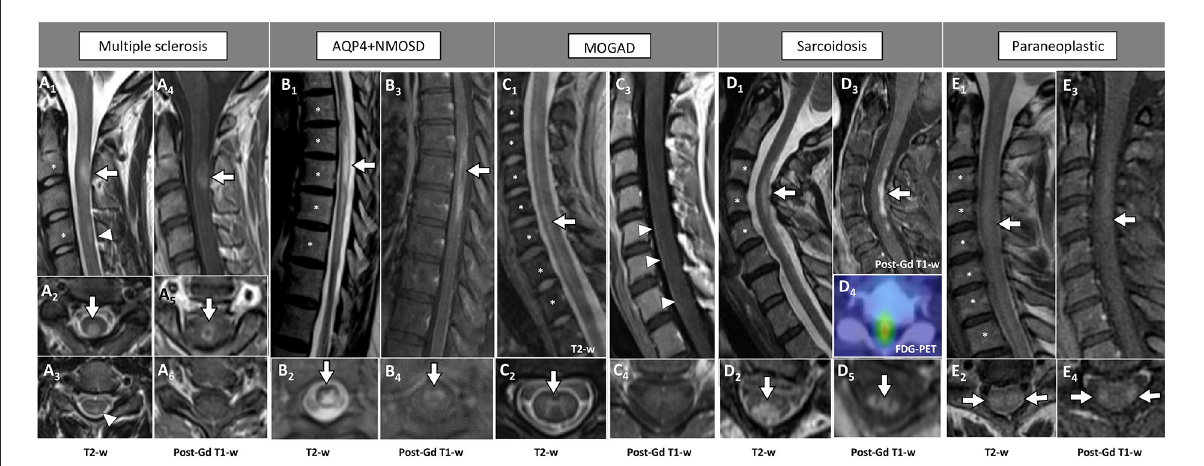
FIGURE1 Examples of inflammatory myelopathies on MRI. The extension of the T2-hyperintensities along consecutive vertebral segments is highlighted by asterisks. [ (A) MS] Acute short cervical lesion with focal spinal cord swelling [ (A 1 ) arrow] involving the central gray matter and the dorsal columns [ (A 2 ) arrow], showing homogeneous enhancement on sagittal view [ (A 4 ) arrow] and a circular ring of enhancement on axial view [ (A 5 ) arrow]. A chronic lesion at the level of C4 is also observed [ (A 1 ) arrowhead], located in the dorsal columns [ (A 3 ) arrowhead] and not showing contrast enhancement (A 6 ) . [ (B) AQP4 + NMOSD] Thoracic spinal cord lesion, longitudinally extensive on T2-weighted images [ (B 1 ) arrow], centrally located [ (B 2 ) arrow], showing lens-shaped ring enhancement on sagittal view [ (B 3 ) arrow], and inhomogeneous enhancement on